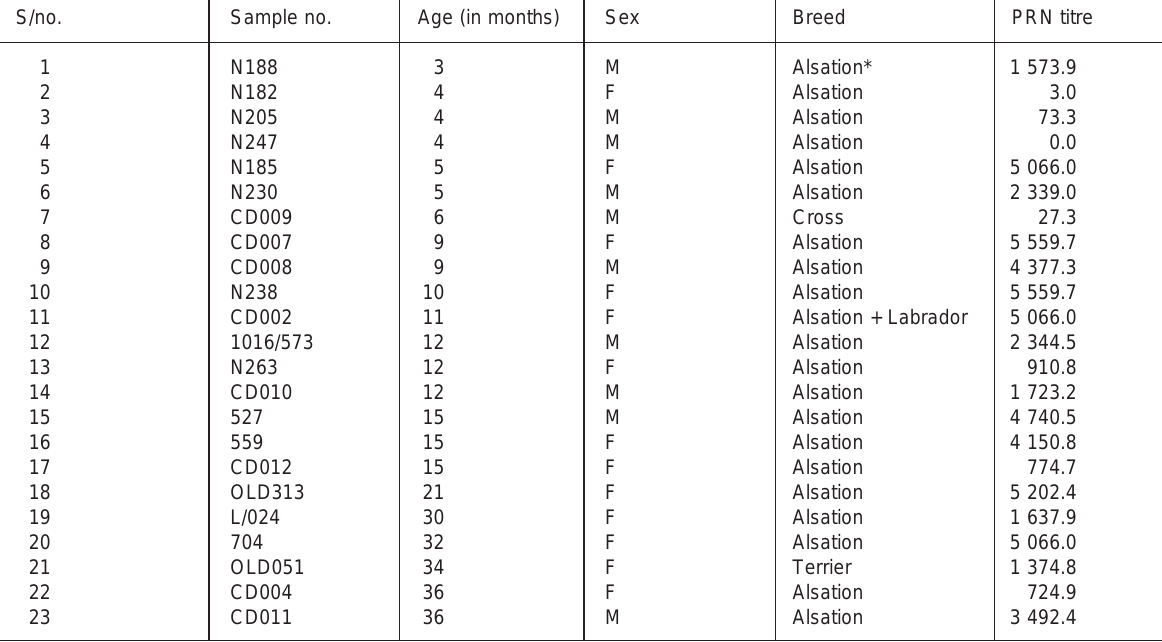
TABLE 1 History and PRN antibody titres of vaccinated dogs S/no. Sample